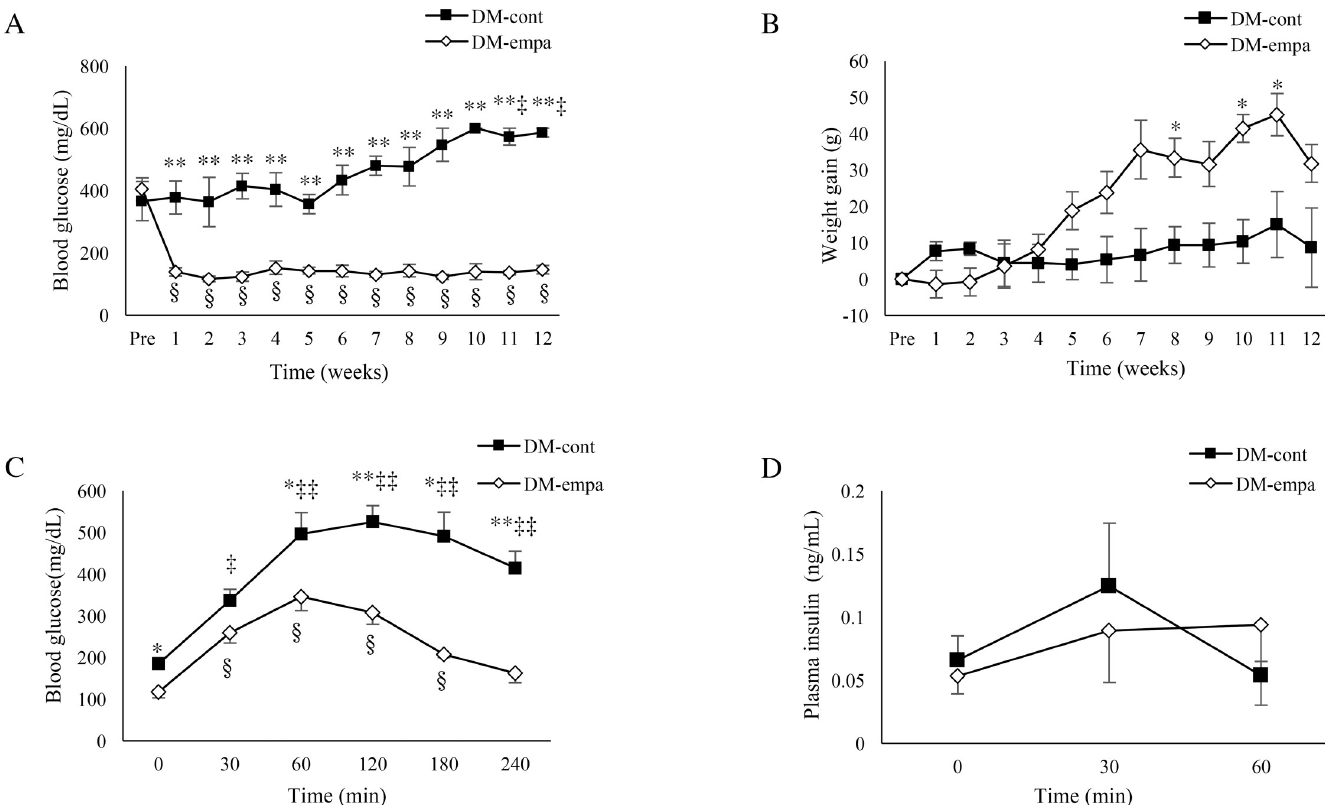
Fig 1. Effects of empagliflozin on blood glucose, body weight gain, and response to glucose loading. Blood glucose levels (A) and the gain of body weight (B) in DM- cont (n = 3) and DM-empa (n = 5) rats over 12 weeks. (C) Blood glucose levels after glucose loading in DM-cont (n = 5) and DM-empa (n = 5) rats. (D) Plasma insulin levels after glucose loading in DM-cont (n = 4) and DM-empa (n = 5) rats. � p < 0.05, �� p < 0.01 for comparisons between the DM-cont and DM-empa groups. ‡ p < 0.05, ‡‡ p < 0.01 for comparisons with pretreatment levels in the DM-cont group, § p < 0.01 for comparisons with pretreatment levels in the DM-empa group.